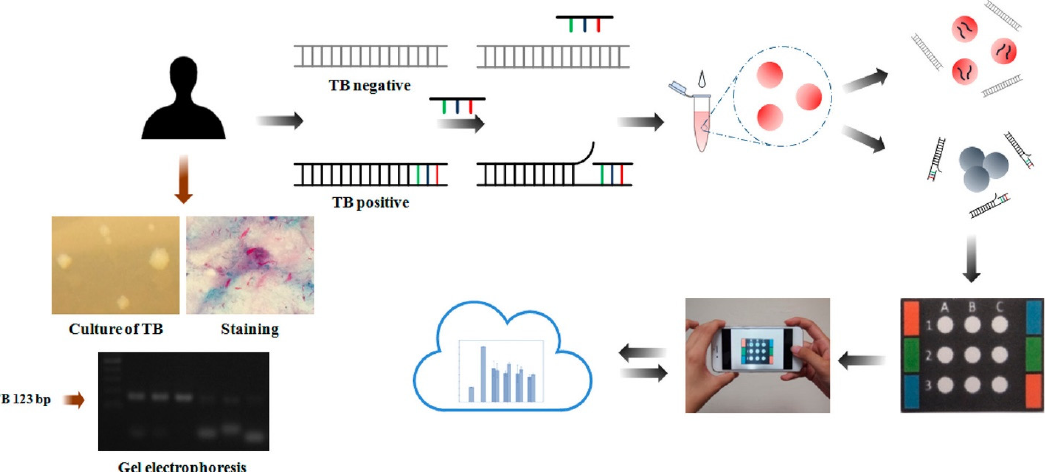
Figure 4. Schematic illustration of gold nanoparticle-assisted colorimetric sensor system using a paper-based analytical device for tuberculosis diagnosis. Reproduced with the permission of [40].